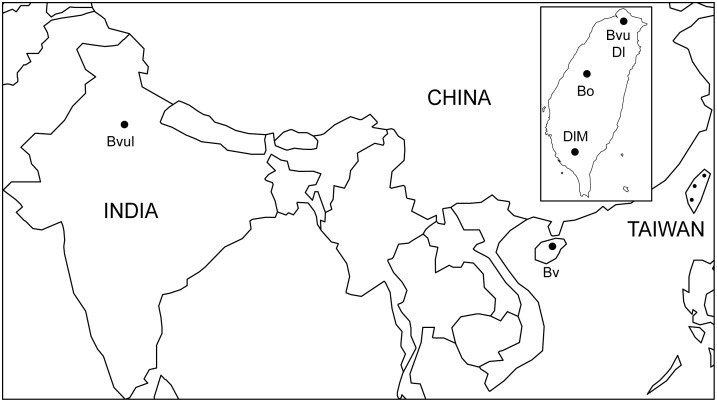
Map showing the geographic locations of collected bamboo samples.Inset shows an enlarged map of Taiwan for clarity. The name designations for each satBaMV populations are: BvuI, from B. vulgaris Schrad. ex J. C. Wendl. at Delhi, India; Bv, from B. ventricosa McClure at Hainan Island, China; Bvu, from Bambusa vulgaris Schrad. ex J. C. Wendl. at Taipei; Dl, from Dendrocalamus latiflorus Munro at Taipei; Bo, from B. oldhamii Munro at Taichung, Taiwan; and DlM, from D. latiflorus Munro cv. Mei-nung W. C. Lin at Pingtung, Taiwan.